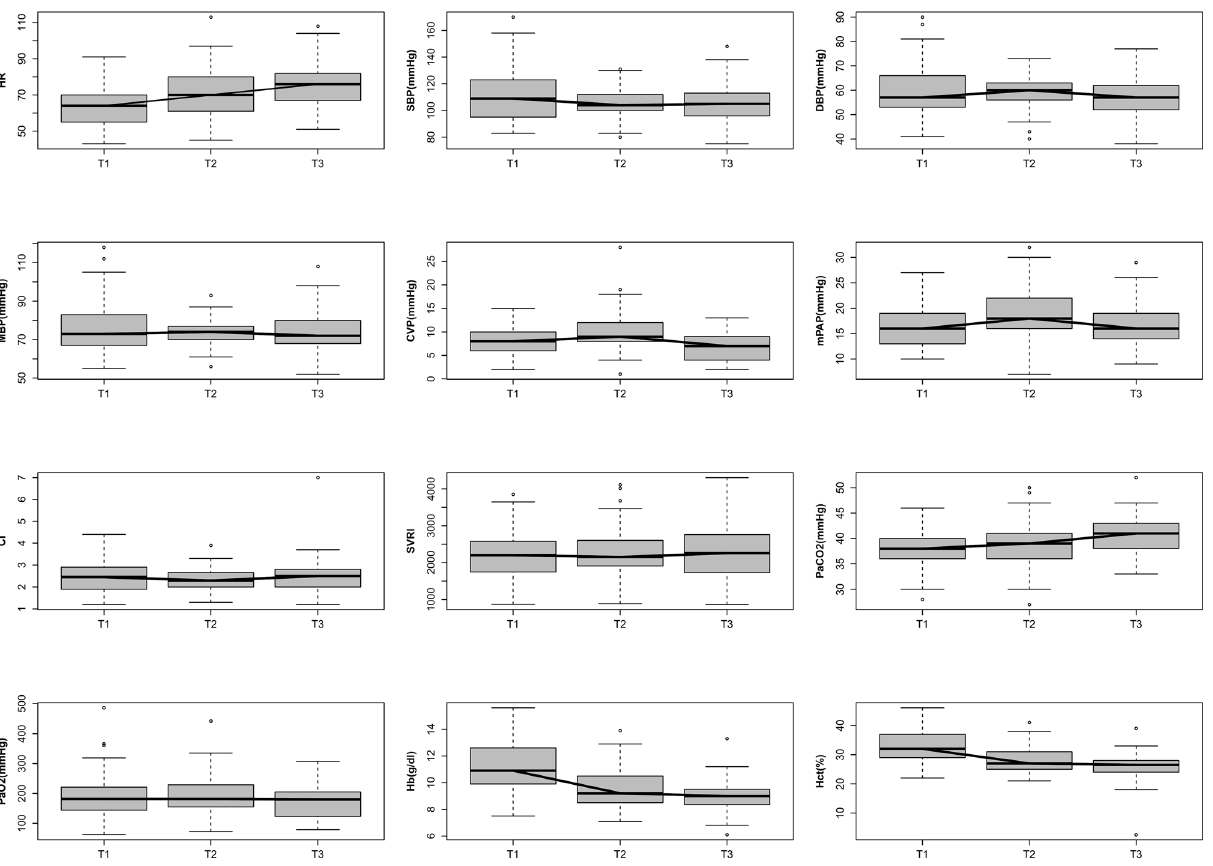
Figure 2. Intraoperative and haemodynamic findings. T1, after anaesthesia induction. T2, after left internal mammary artery (LIMA) to left anterior descending artery (LAD) anastomosis. T3, before sternal closure. HR